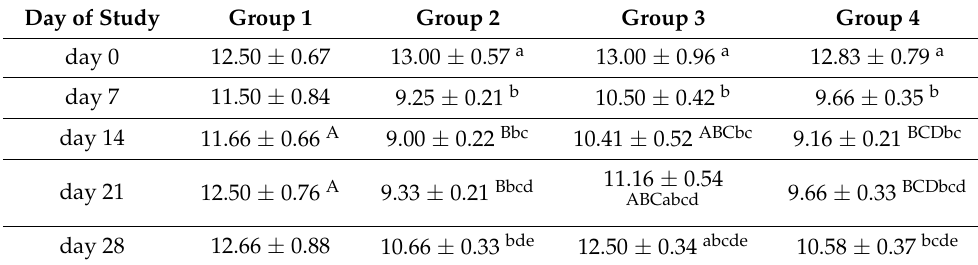
Table 4. Effect of adjuvanted, sonicated antigens on Hb (g/dL) in